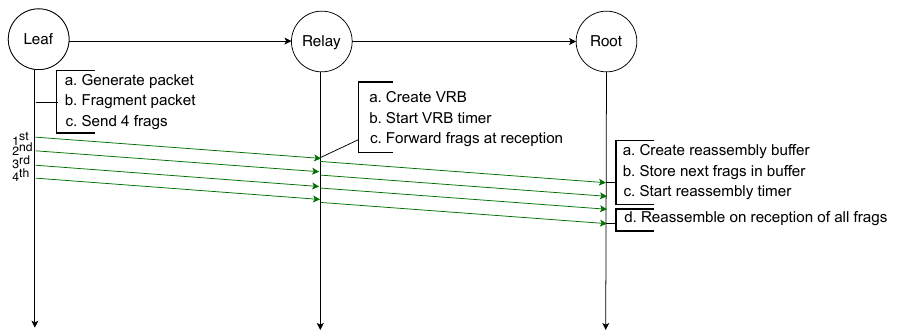
Figure 5. Successful transmission of a fragmented packet over two hops with MFF.